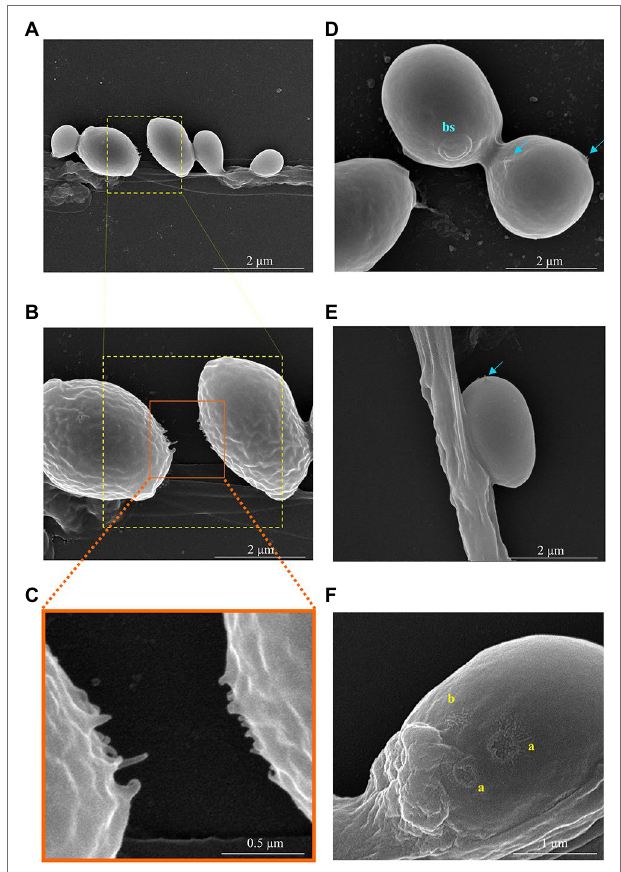
FIGURE 7 | SEM micrographs showing the details of the interaction between two W. anomalus #1105 yeast cells during the antagonistic action against M. perniciosa CBS 442.80. (A-C) Increasing magnification of the fimbriae-like structures connecting two yeast cells. (D,E) Blue arrows indicate forming protrusions; bs stands for bud scar having app. 700 nm Ø. An internal granulated structure is visible, each grain with app. 30–40 nm Ø. (F) Yellow letters indicate the scars of previous sections connecting yeasts, which present two different shapes (a) open/recent scar with 200–300 nm Ø and (b) probably a closed